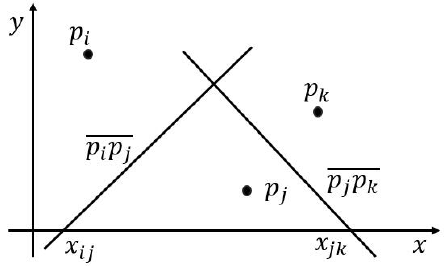
Figure 8. An Example of Maintaining Point p j .